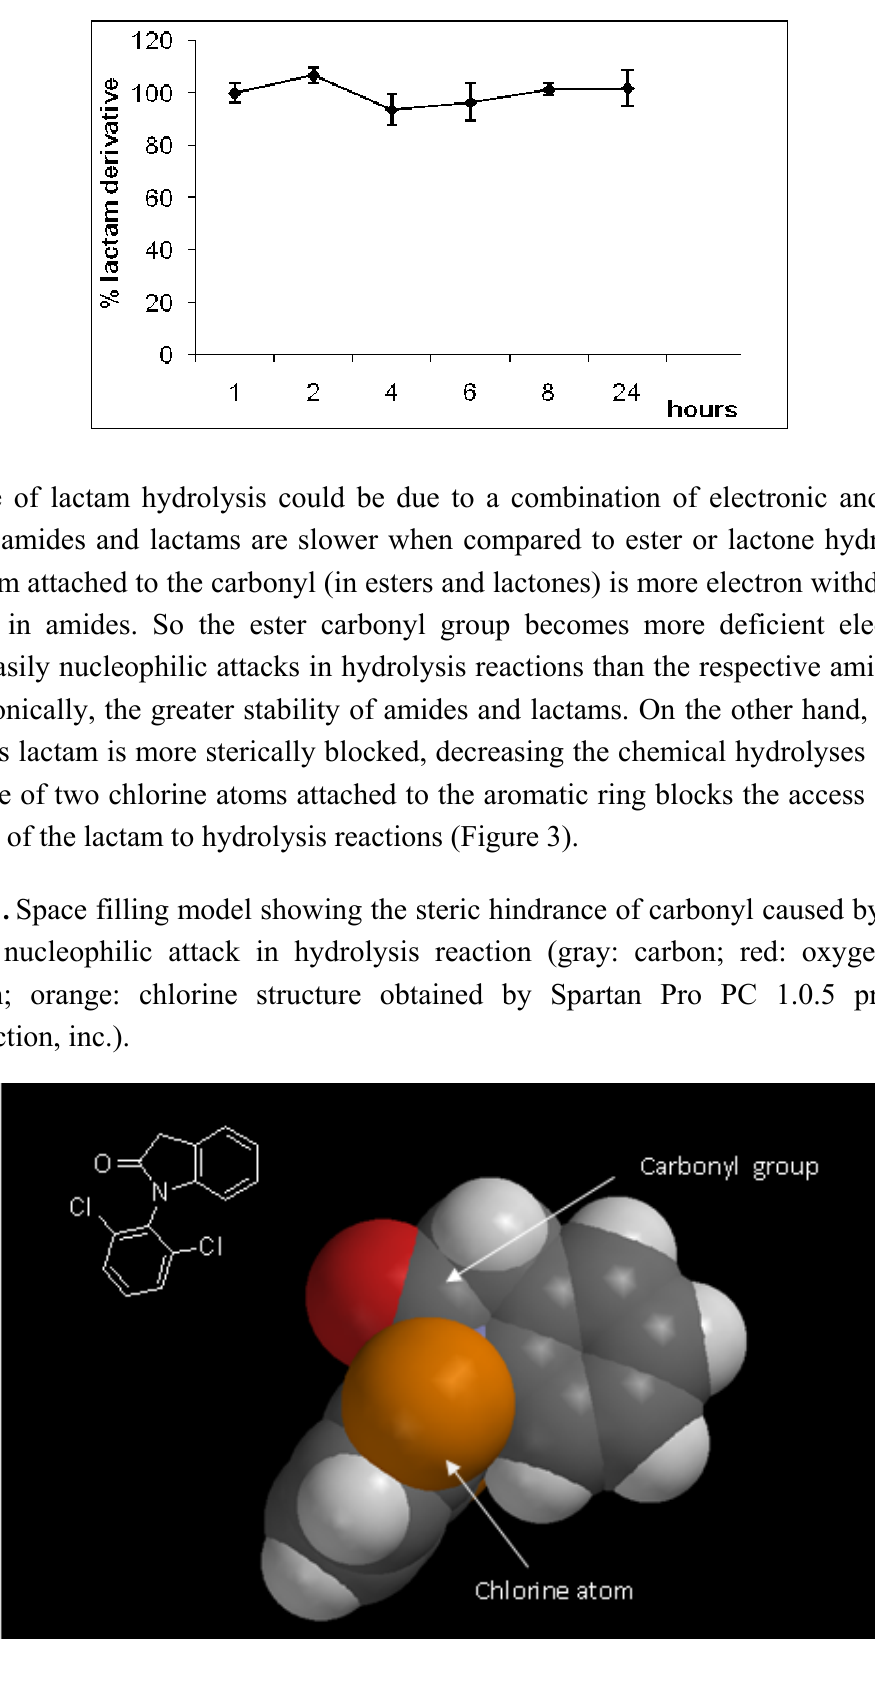
Figure 2. Hydrolysed percentage of lactam derivative in plasma (data are represented as mean ±S.E.M., n = 8, P < 0.01).